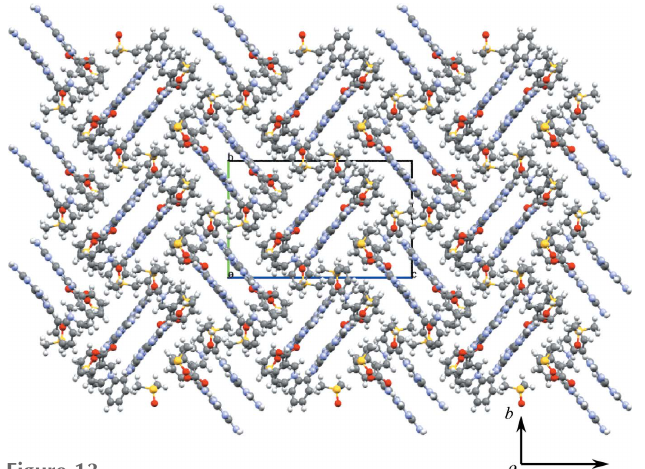
Figure 13 The three-dimensional packing diagram to show the molecules of 1 arranged as zigzag double ribbons in the crystal structure of 1f (cid:3) DMSO.